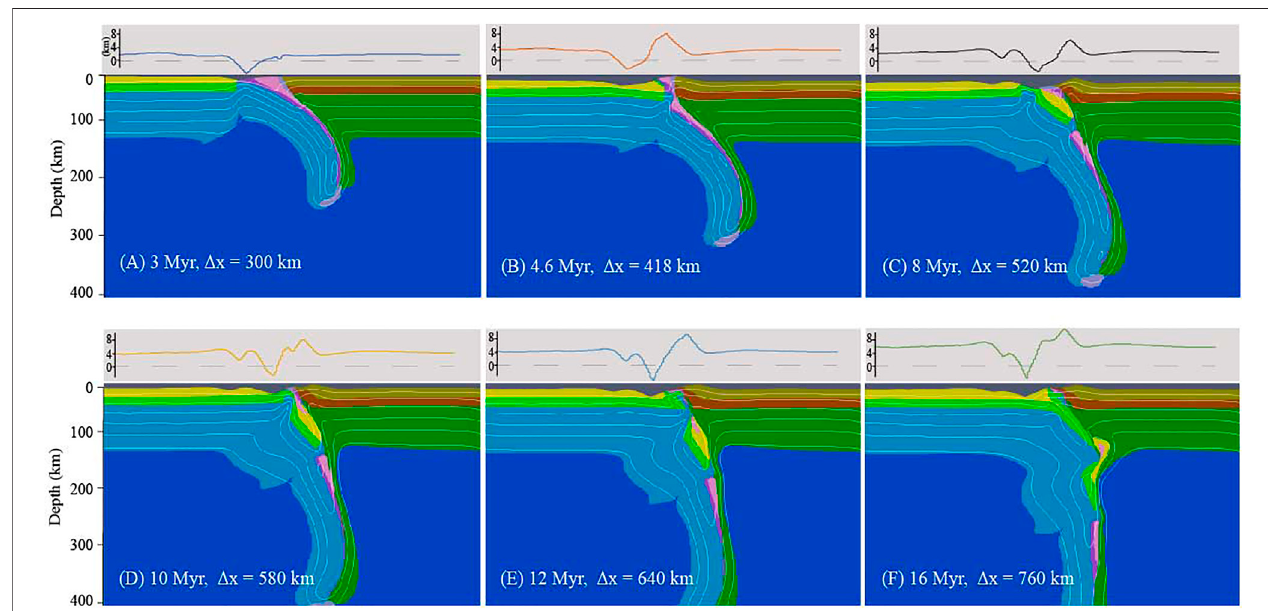
FIGURE 6 | Evolution of the stable continental collision mode. Panels above each snapshot with gray shading show the corresponding topography. Δ x is the amount of convergence. Different colors in (A – F) denote different lithologies (same as Figure 2 ).